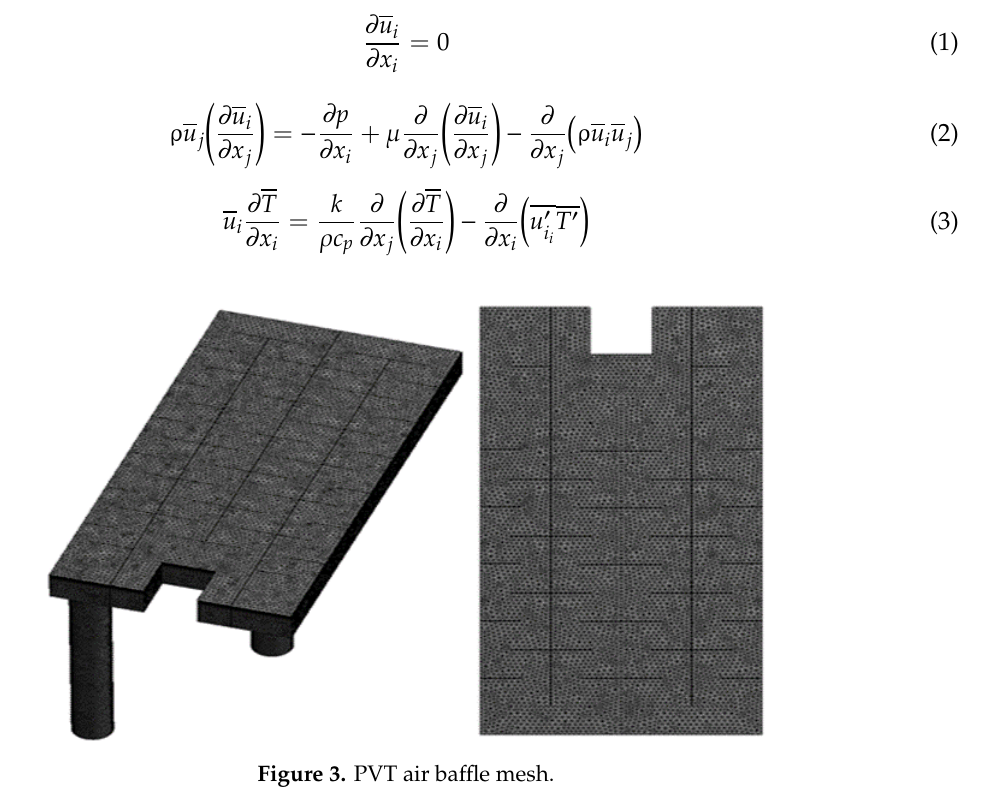
Figure 3. PVT air baffle mesh.